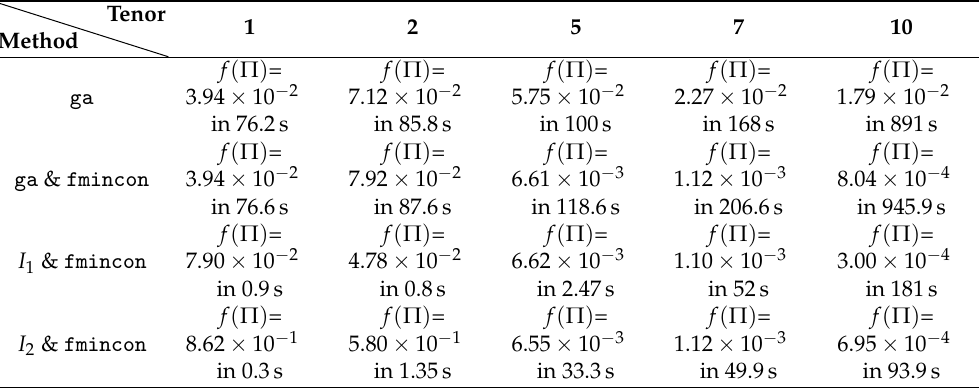
Table 1. Computational times and values of (12) using different initial points and different swaption columns in Table A3 and corresponding strikes in Table A2 in the case of payer swaptions and maturities ranging from 5 to 15.